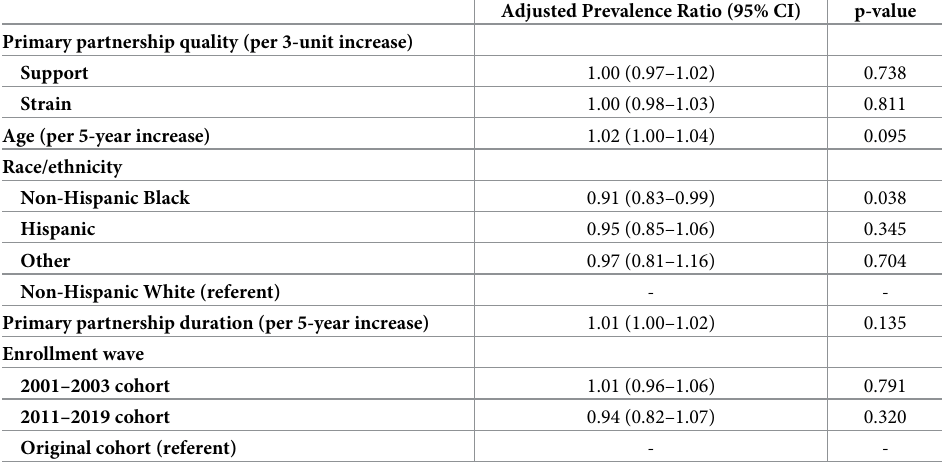
Table 4. Adjusted association of partnership quality and viral load suppression among participants reporting pri- mary partnerships.